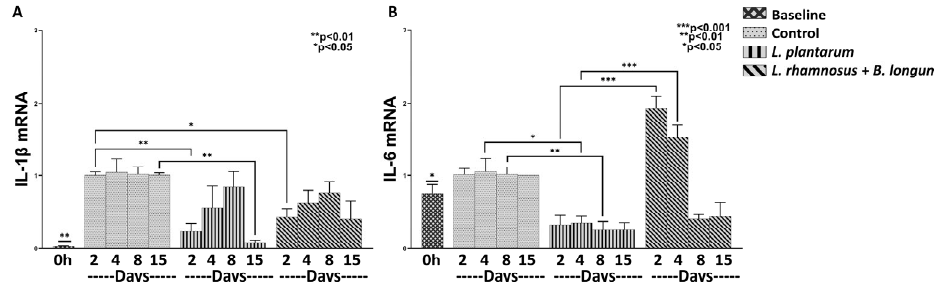
Figure 1. The effects of L. plantarum and the combination of L. rhamnosus – B. longum on the pro ‐ inflammatory response. The mRNA expression of IL ‐ 1 β ( A ) and IL ‐ 6 ( B ) during the course of the healing process. Results are presented as means with SEM. IL ‐ 1 β Baseline: ** p < 0.01 compared to Control (Days 2–15), L. plantarum (Days 2–8) and L. rhamnosus and B. longum (Days 2–15); IL ‐ 6 Base ‐ line: * p < 0.05 compared to L. plantarum (Days 2–8) and L. rhamnosus and B. longum (Days 2–8).